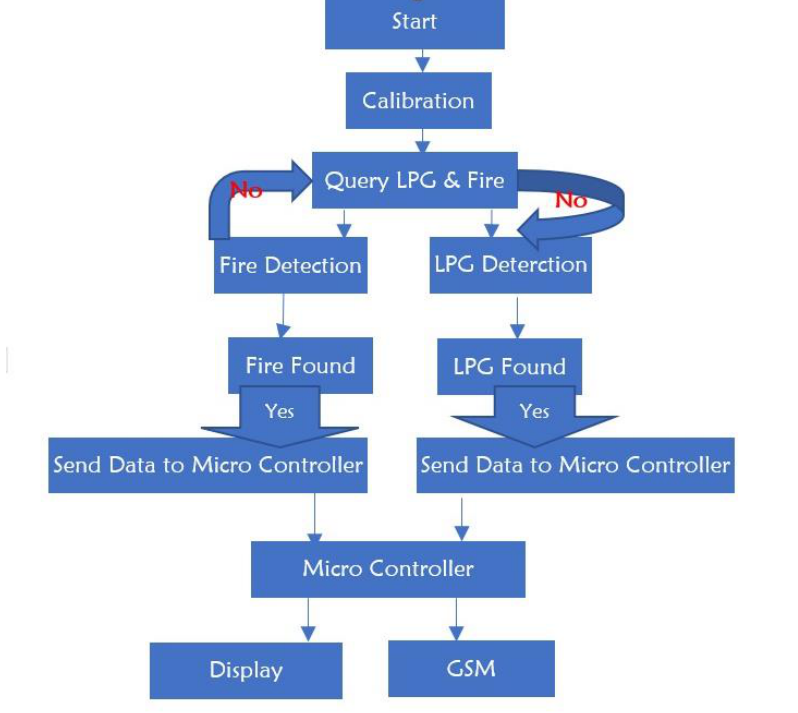
Figure 3: Algorithm for detecting gas leakage